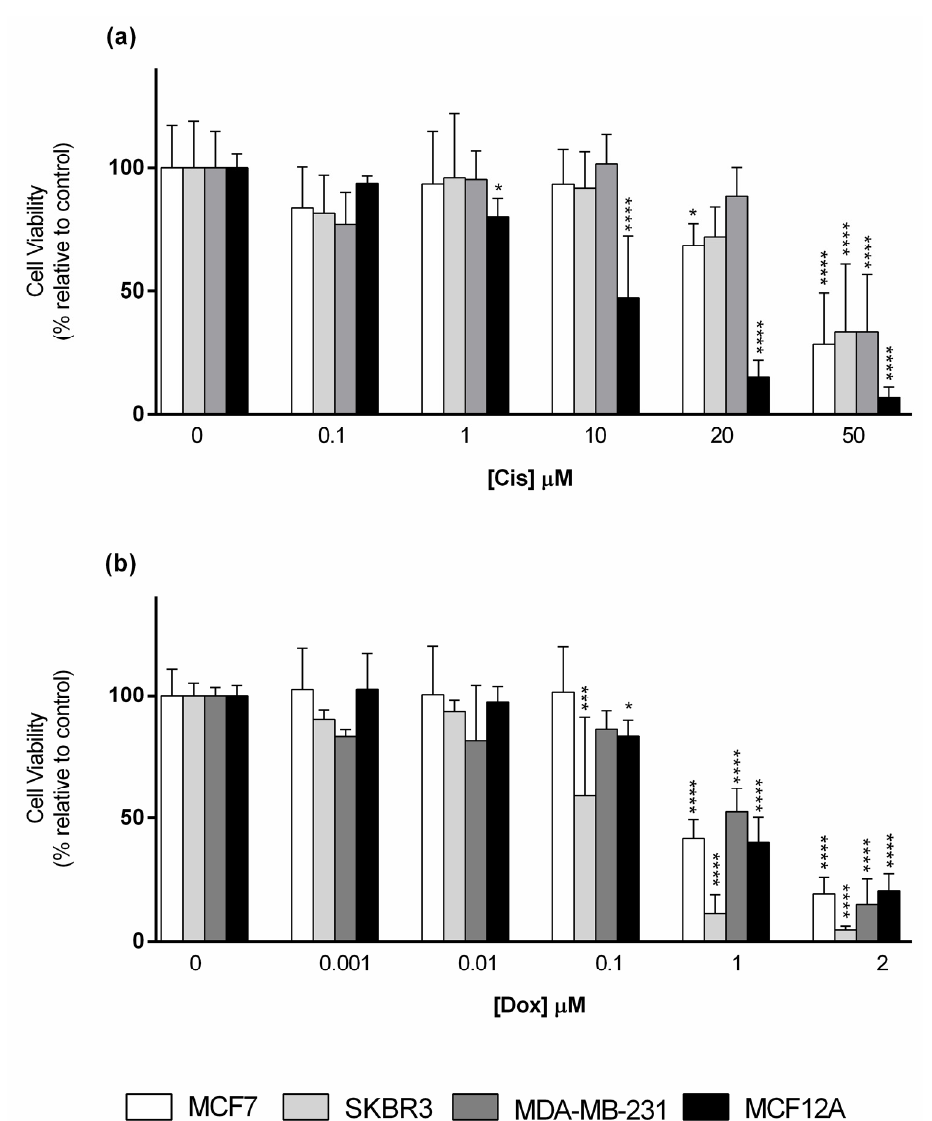
Figure 3. Cytotoxic effect of ( a ) Cisplatin (Cis); ( b ) Doxorubicin (Dox) assessed by the MTT assay after 72 h of exposure in the panel of breast cell lines cultured in monolayer. Control corresponds to cells incubated with medium containing 0.1% DMSO. The percentages of cell viability are relative to the controls and presented as mean + standard deviation of six independent experiments (each in triplicate). (* p < 0.05, *** p < 0.001, **** p < 0.0001).